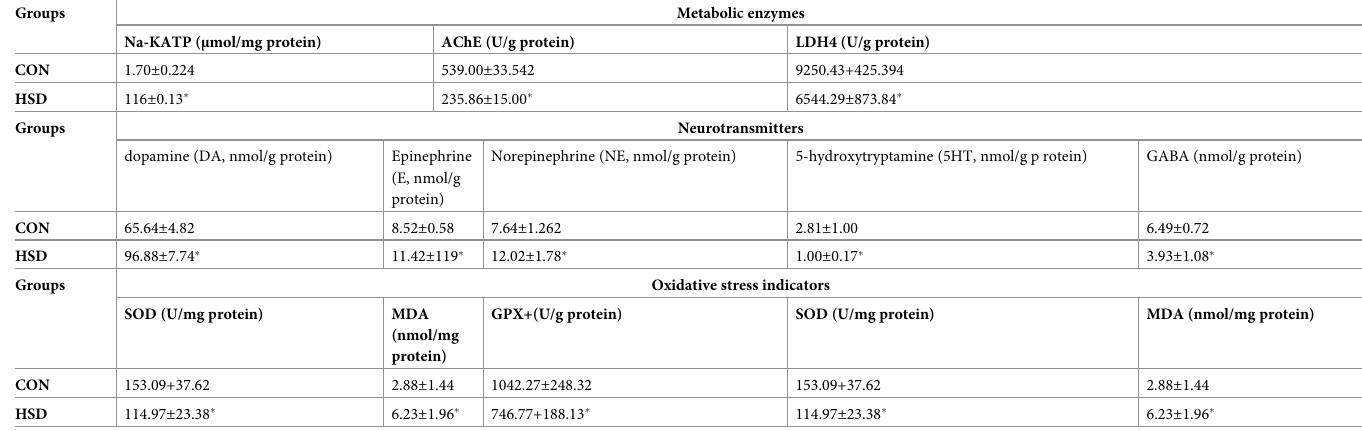
Table 1. The quantification of biochemical parameters measured in cortex tissue CON and HSD animals by ELISA with the assay kits. (mean ± S.D.). � indicates sta- tistical significance. Groups Metabolic